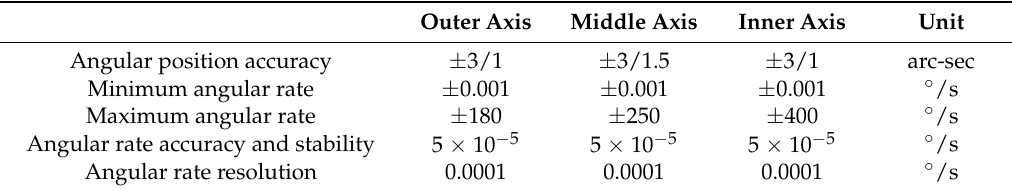
Figure 15. The high-precision three-axis turntable and the inertial measurement unit (IMU) in the temperature control box. Table 3. The main parameters of the three-axis turntable.